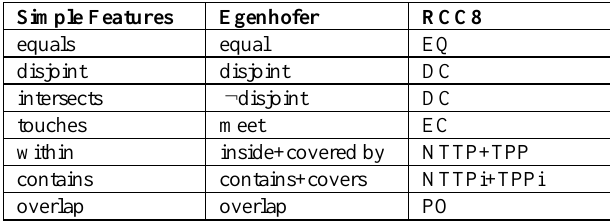
Table 1 . Topological relations; Simple Features, Egenhofer